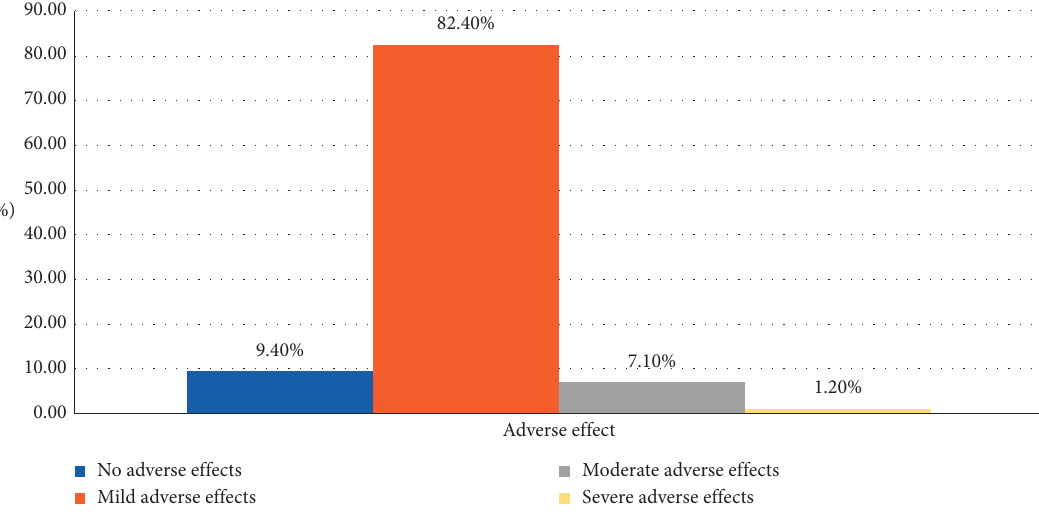
Figure 5: The results of adverse effects including scares, herpes labialis, severe crust, bleeding, and swelling.